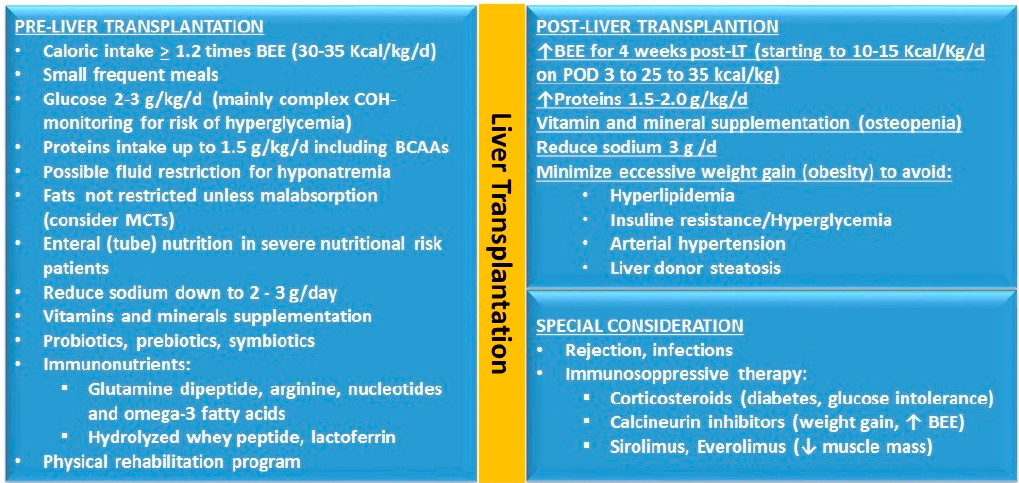
Figure 4. Nutritional interventions before and after liver transplantation. BEE: basal energy expenditure; BCAA: branched chain amino acids; COH: carbohydrates; MCTs: mean chain triglycerides; LT: liver transplantation; POD: post operative day.